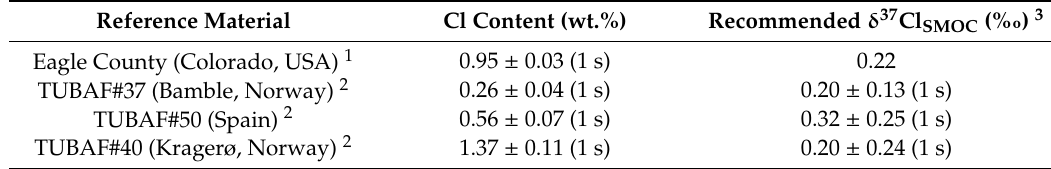
Table 2. List of Secondary Ion Mass Spectrometry (SIMS) reference materials used in this